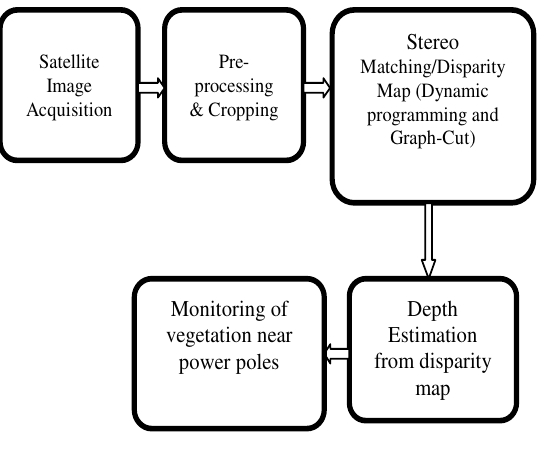
Figure 1. Proposed framework for monitoring of vegetation near power poles